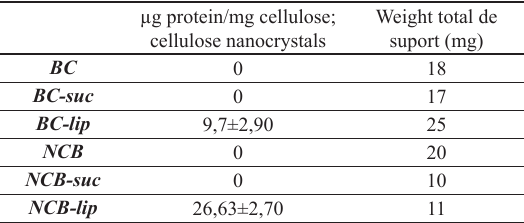
Table 1. Protein concentration immobilized on bacterial membrane and nanocellulose. µg protein/mg cellulose; cellulose nanocrystals